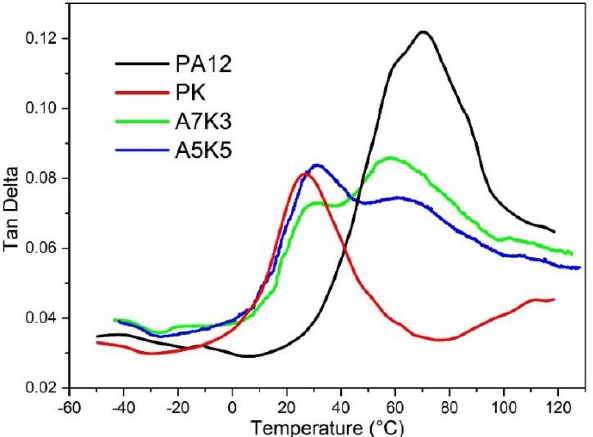
Figure 4. Loss tanδ vs. temperature for pure PA12, PK and blends of A5K5, A7K3.